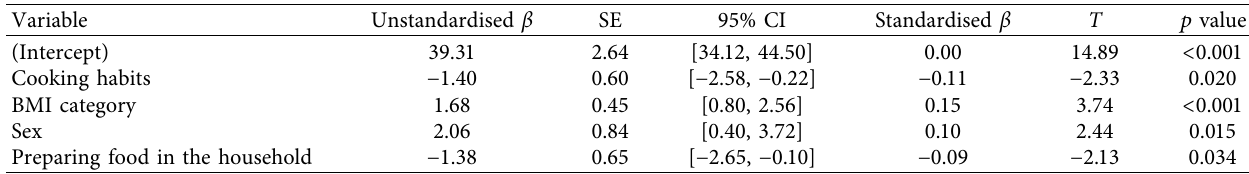
Table 5: Multiple linear regression of nutrition knowledge on sex, BMI, cooking habits, and who is responsible for preparing food in the